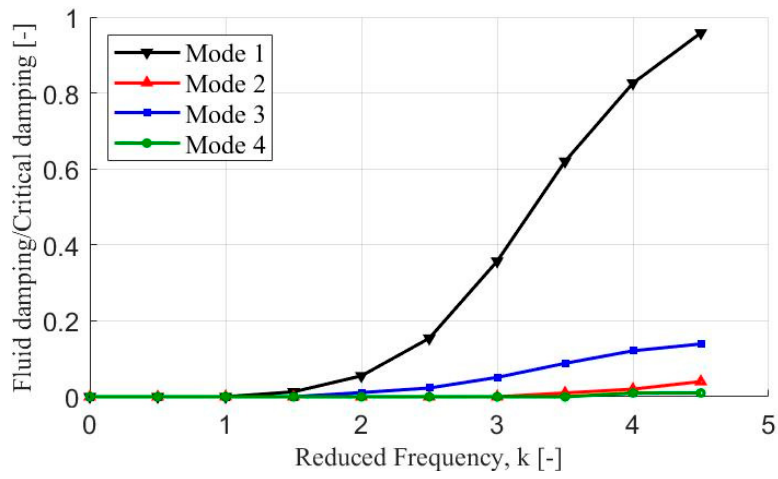
Figure 11. Fluid damping ratio as a function of reduced frequency for cantilever trapezoidal plate.